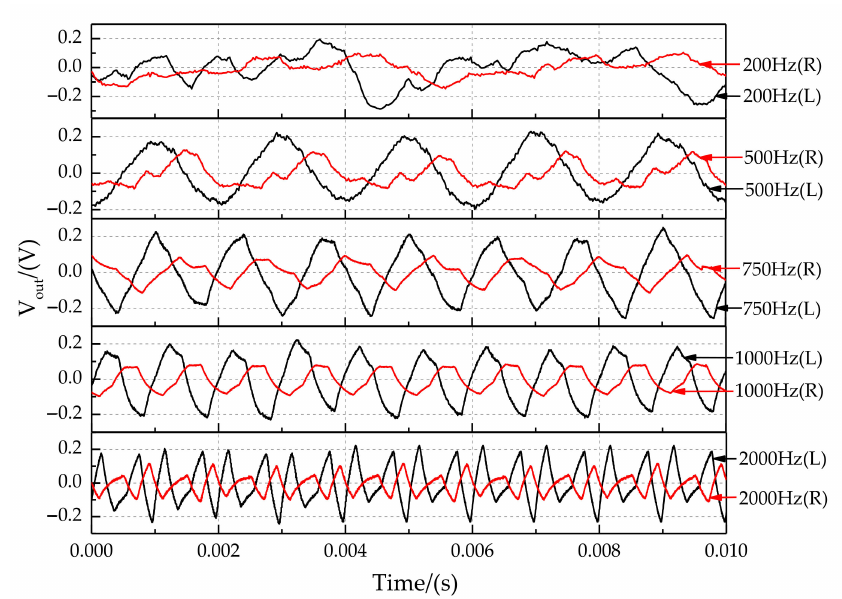
Figure 19. Characteristics of output signals at the sound source frequency of 200 Hz, 500 Hz, 750 Hz, 1000 Hz, and 2000 Hz.